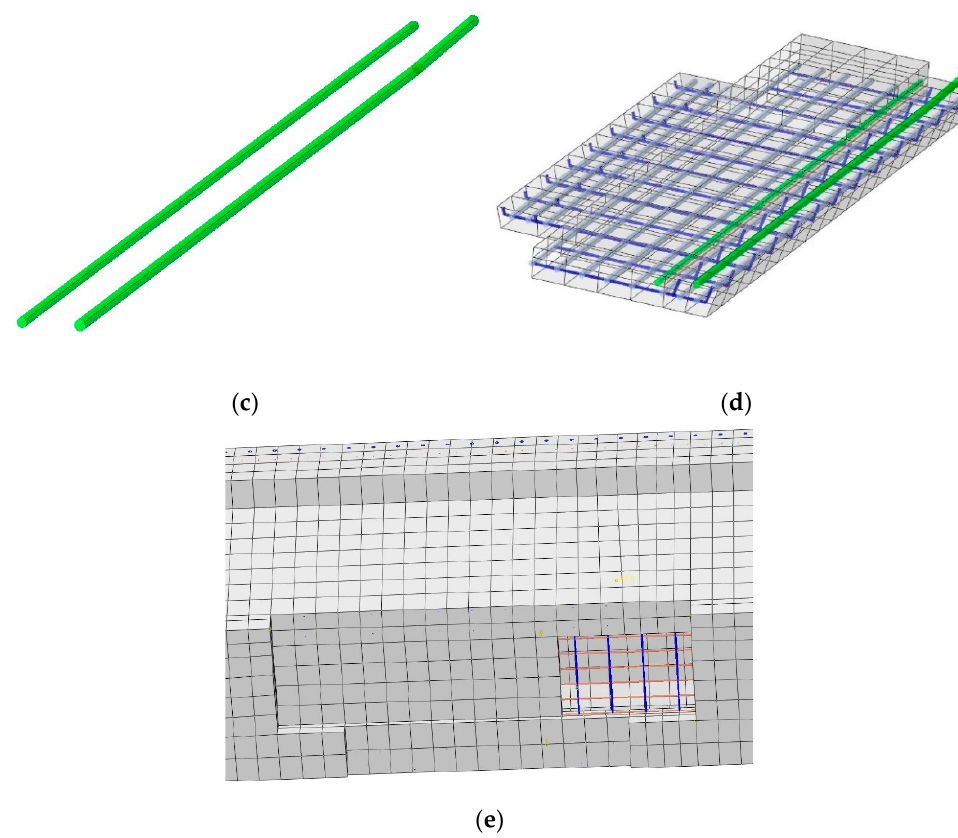
Figure 12. Details in the damaged district of the #3-2 girder. ( a ) The damaged part of concrete; ( b ) The damaged part of the steel bars; ( c ) The damaged part of the pretensioned strands; ( d ) The damaged part; ( e ) The damaged area of the girder.